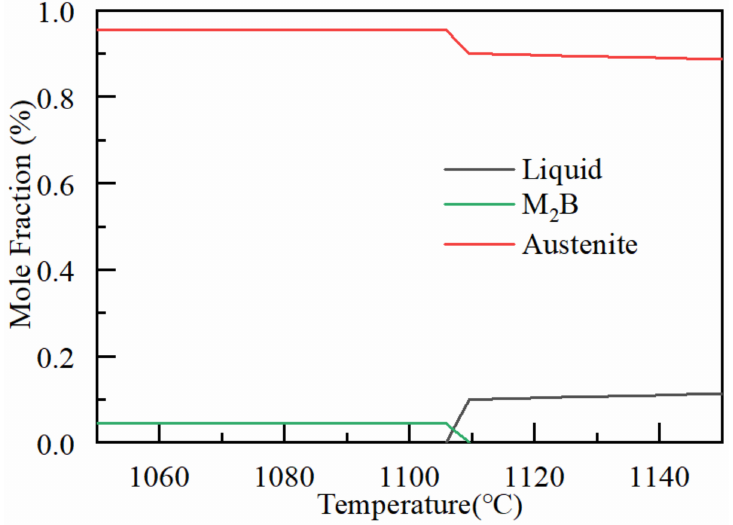
Figure 7. Calculated phase map of 30B steel by Thermal Calc